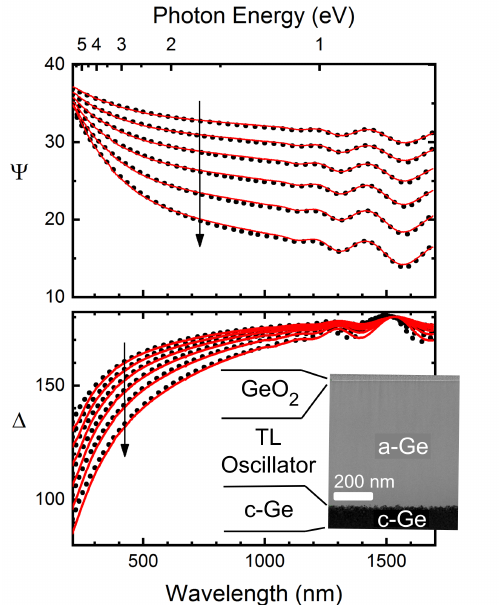
Figure 3. Measured (solid lines) and generated (dotted lines) ellipsometric Ψ and ∆ spectra for the Al-implanted Ge sample. The two-layer optical model and the corresponding XTEM micrograph is shown in the inset. The fitted thicknesses of the surface oxide (GeO 2 ) and a-Ge (TL oscillator) layers are 1.61 ± 0.03 and 679.4 ± 0.3 nm, respectively. Note that the top part of the XTEM image is the glue used for the sample preparation. The 1.6-nm oxide itself is not visible. The arrows show the direction of increasing angles of incidence from 53 ◦ in steps of 3 ◦ .